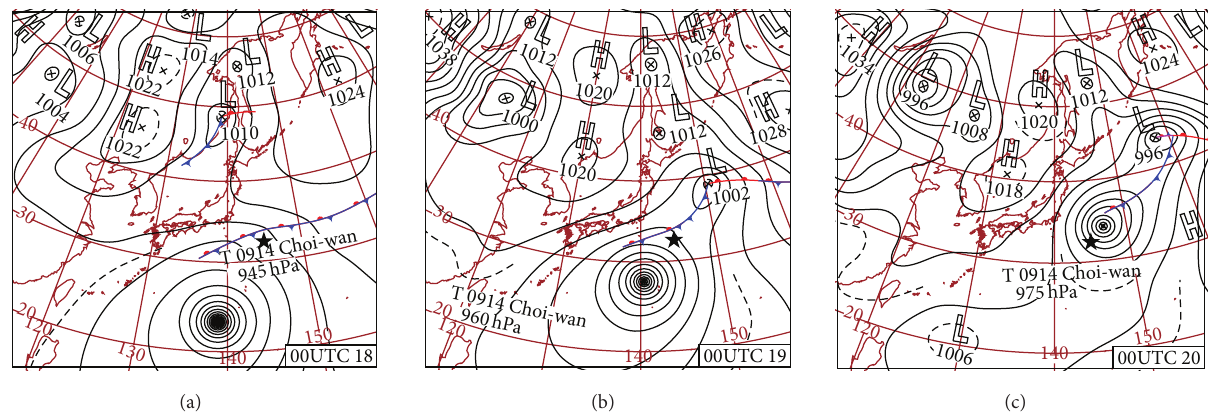
Figure 9: Weather maps from the Japan Meteorological Agency for (a) 0000 UTC on September 18, (b) 0000 UTC on September 19, and (c) 0000 UTC on September 20. A star mark indicates the location of the KRO buoy.